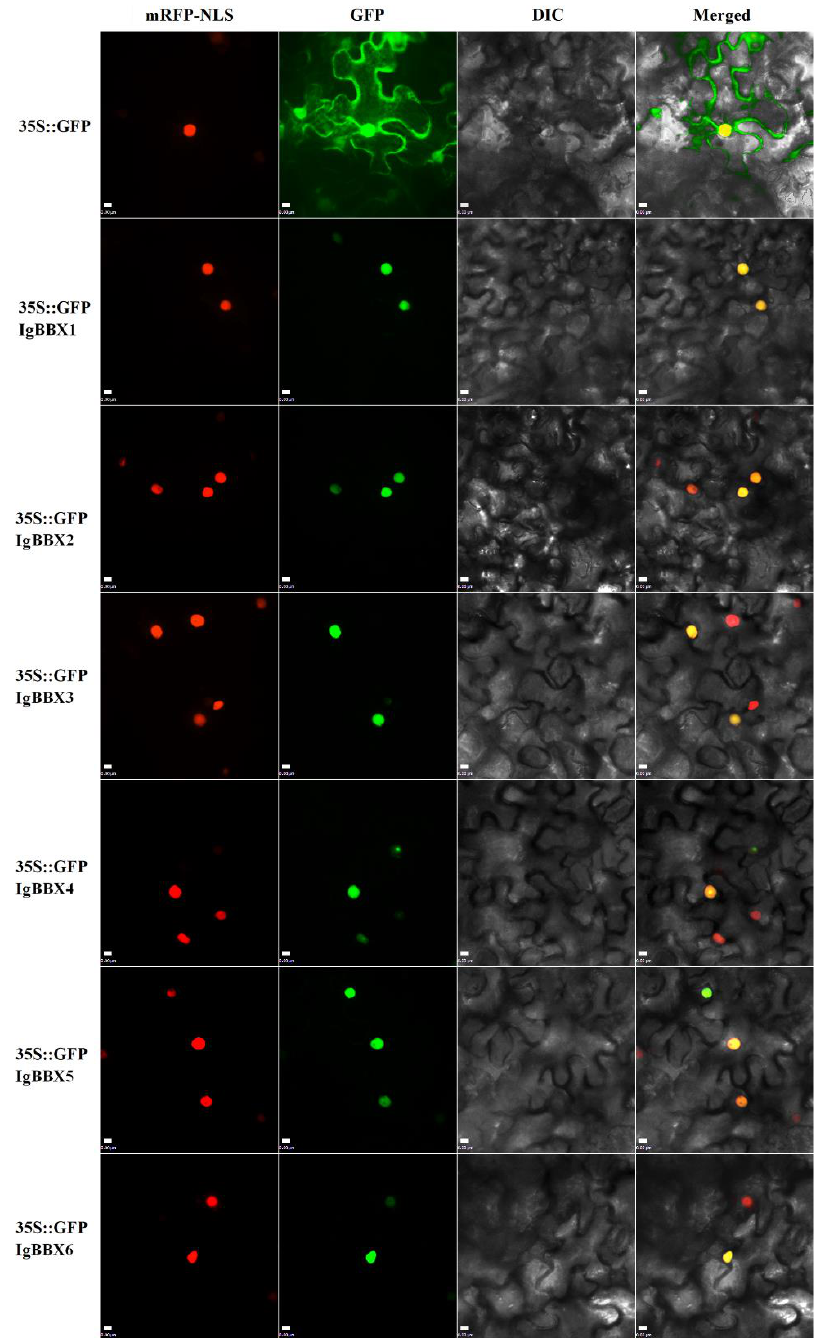
Figure 2. The subcellular localization of transiently expressed IgBBX TF fusion transgene in tobacco ( N. benthamiana ). The upper row shows the effect of the control p35S::GFP transgene and the lower rows that of the test transgene p35S:: GFP - IgBBX . Bars = 50 µ m. mRFP-NLS: a mRFP-labelled nuclear marker.